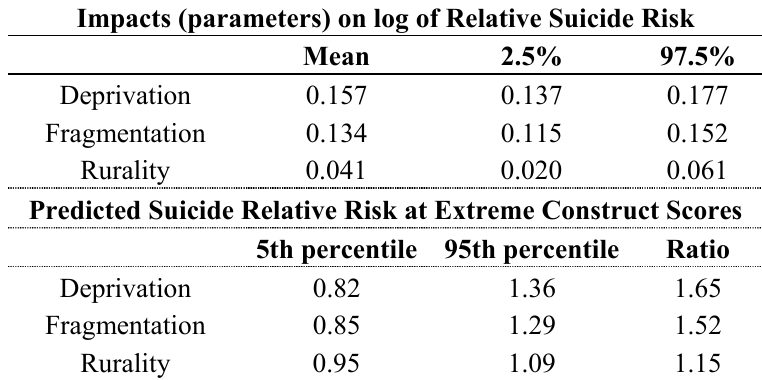
Table 2. Regression coefficients and predicted relative risks, suicide